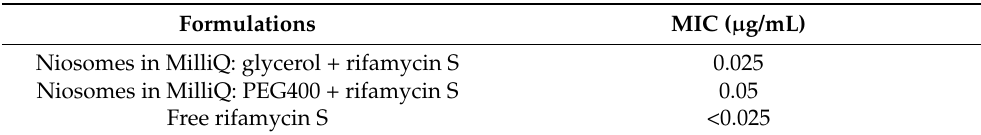
Table 2. MIC values of niosomes hydrated with glycerol and PEG400 solutions with rifamycin S versus that of free rifamycin